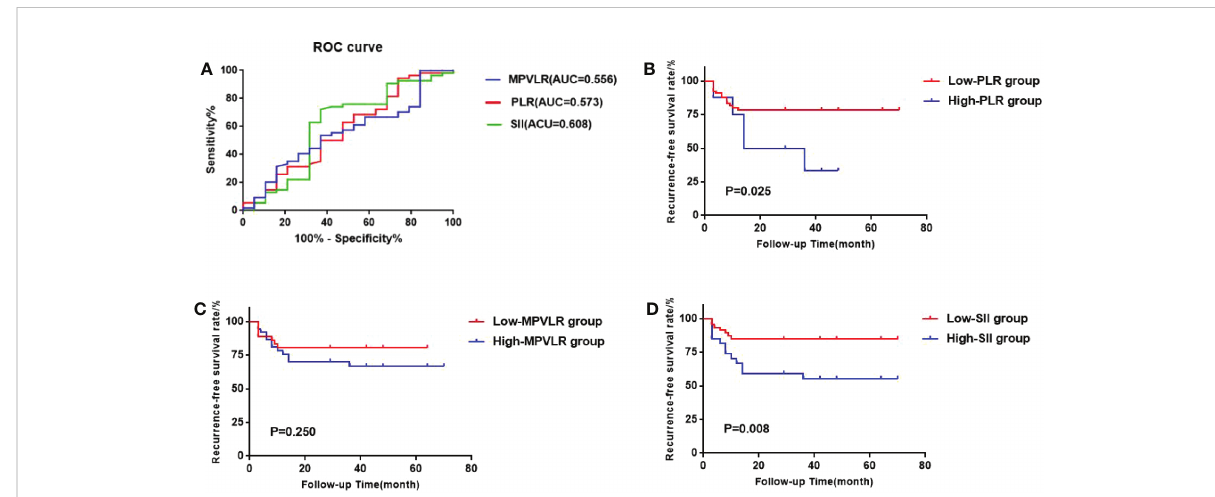
FIGURE 3 (A) ROC curves of the best cutoff values of PLR, MPVLR, and SII of the CHT group. (B) Comparison of survival curves between the high PLR group and the low PLR group. (C) Comparison of survival curves between the high MPVLR group and the low MPVLR group. (D) Comparison of survival curves between the high SII group and the low SII group.